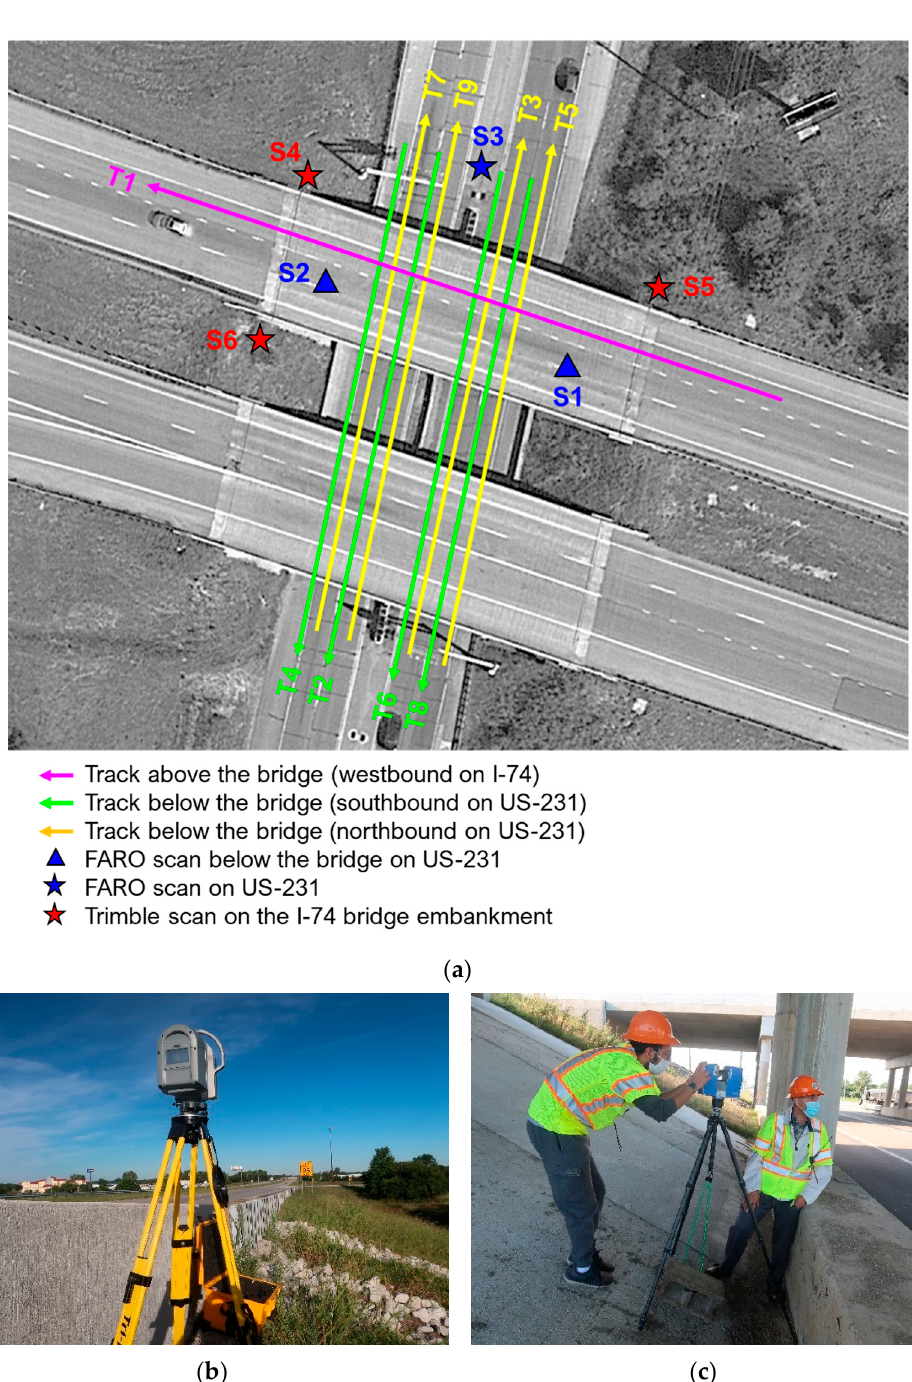
Figure 3. Data acquisition: ( a ) drive run configuration for the vehicles (Tracks T1–T9) and TLS scan locations (Scans S1–S6), ( b ) image of the Trimble station (Scan S4) atop the I-74 embankment outside the barrier rail, and ( c ) image of the FARO station (Scan S1) on the US-231 under the I-74 bridge.